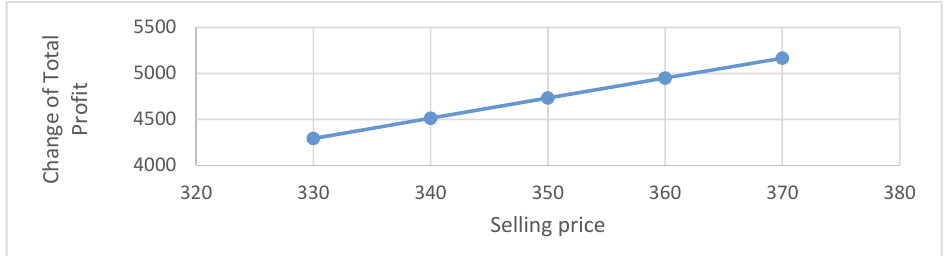
Fig. 7. Effect of selling price on total profit of the inventory